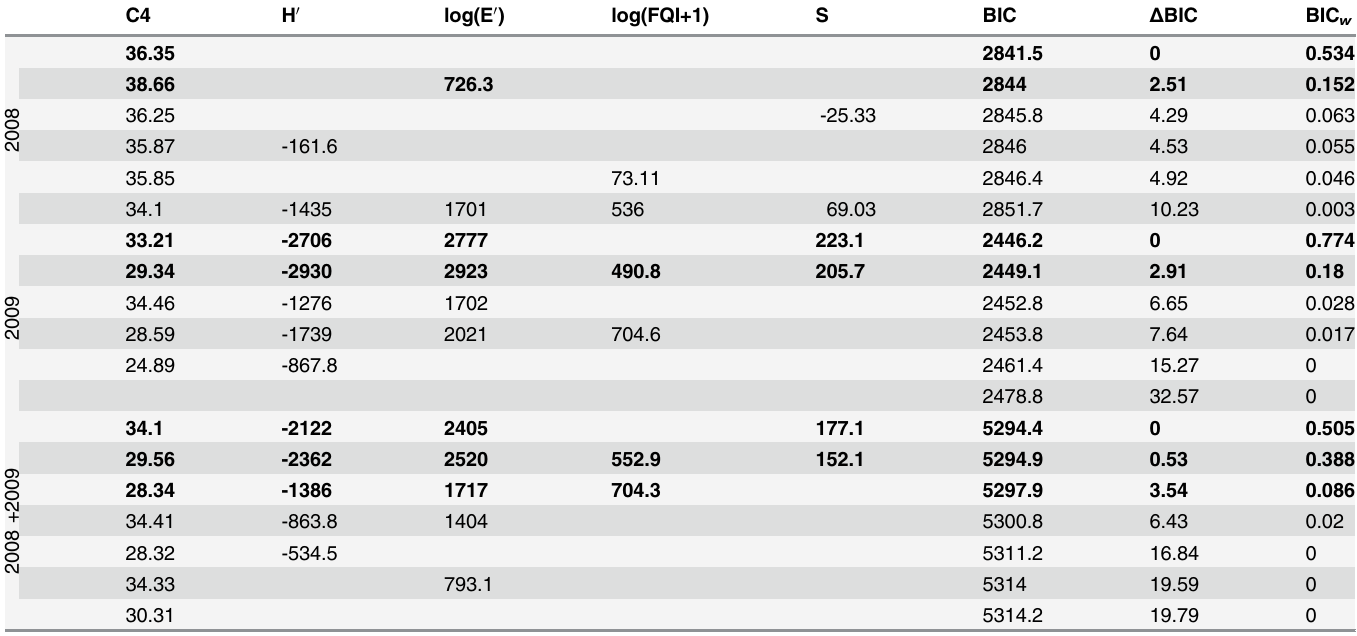
Models in bold were used in model averaging